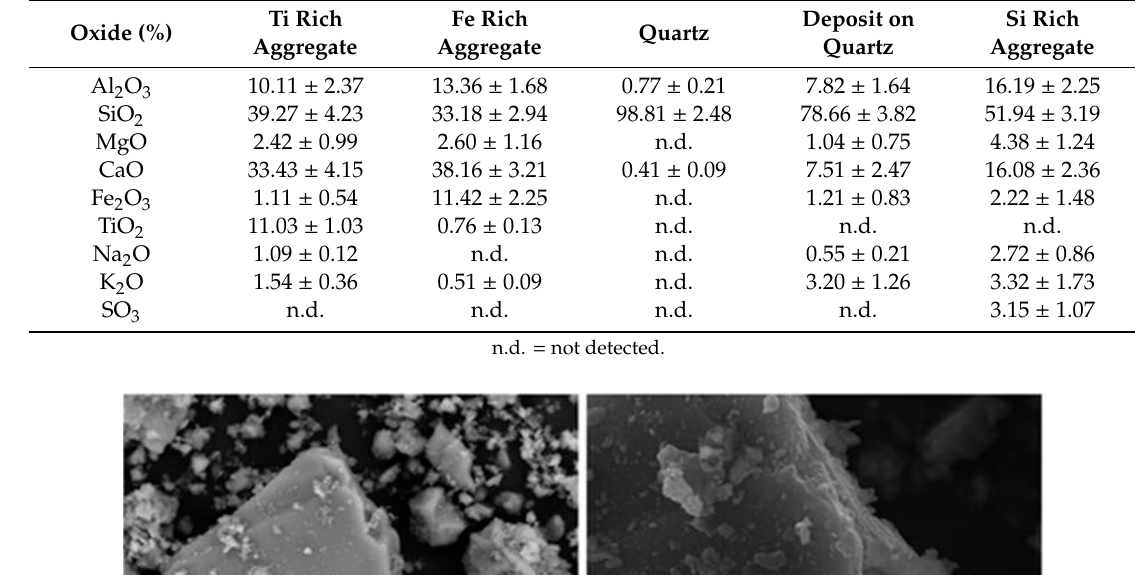
Table 4. Energy dispersive X-ray spectroscopy (EDX) chemical analysis of siliceous waste.